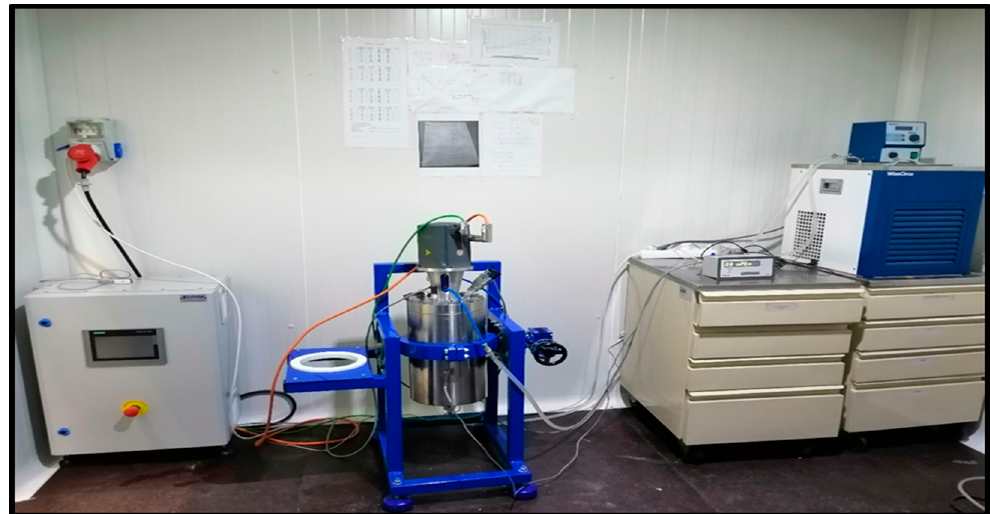
Figure 1. Methane–propane hydrate formation reactor connected with control unit ( left ) and cooling bath ( right ).